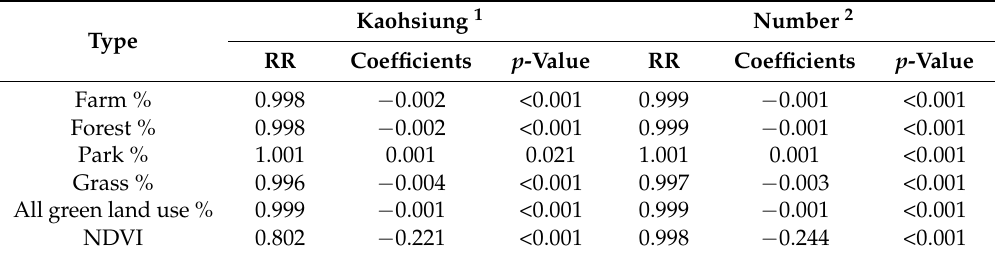
Table 3. The Association between Surrounding Greenness and the Dengue Epidemic Kaohsiung and Number of